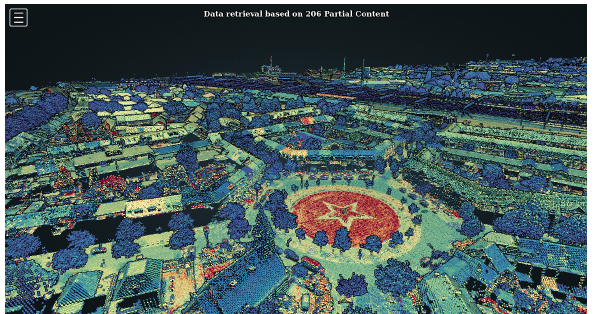
Figure 1. Points from the Actual Height model of the Netherlands (AHN3) data set colored by ‘intensity gradient’ visualized by Potree, retrieved from PCServe using